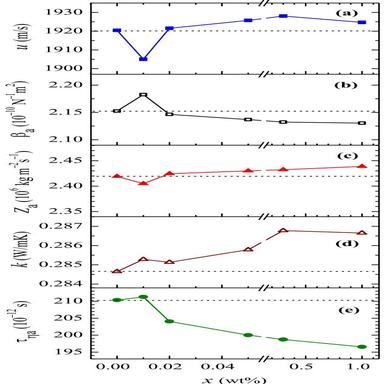
Variation of u, ba, Za, k, and sga with x (wt%) amounts of ZnO for the GLY/x (wt%) ZnO nanofluids, at 25 C.